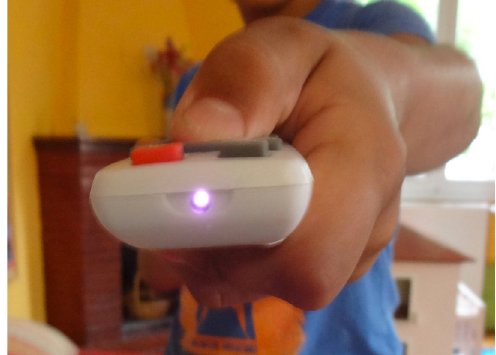
Fig. 3. The remote control emits infrared electromagnetic radiation